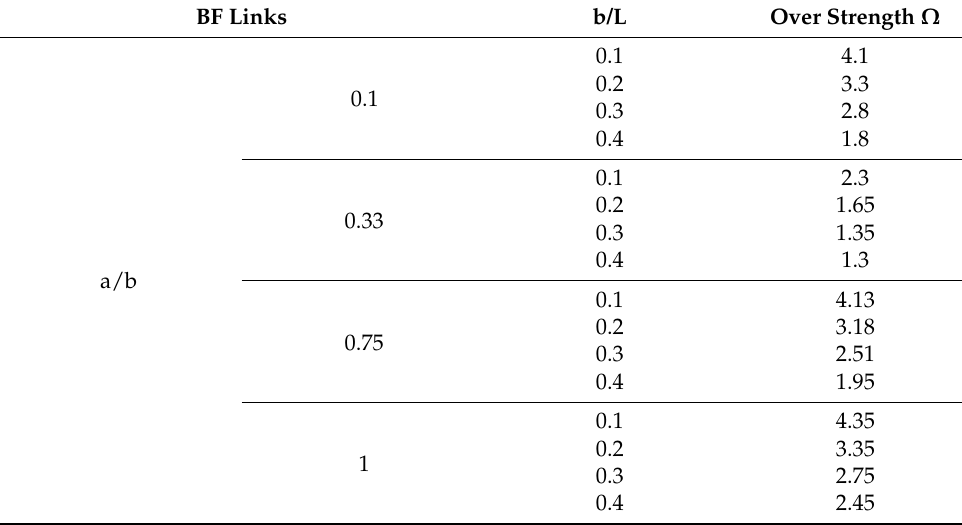
Table 1. The over strength factor established for butterfly-shaped